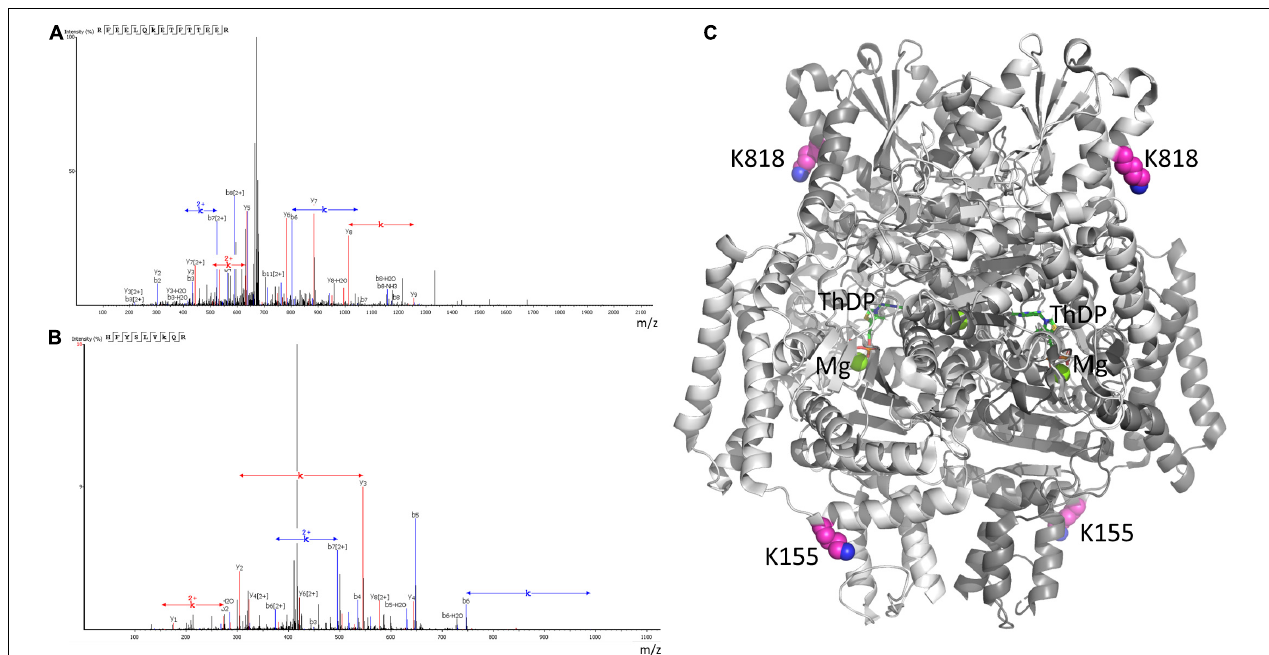
FIGURE 8 | Mass-spectrometric identification of OADH glutarylation. The glutarylation of lysine K155 and K818 is identified by LC-MS in human recombinant OADH expressed in yeast. (A) The spectra of the peptide with glutarylated K155, namely RFEELQK(+114.03)ETFTTEER, m/z = 686.3347, retention time (RT) = 96.49; (B) the spectra of the peptide with glutarylated K818, namely HFYSLVK(+114.03)QR, m/z = 431.2349, RT = 82.38; (C) localization of the identified glutarylated residues (the carbon atoms marked in pink) in the OADH dimer. The available structure of the enzyme dimer crystallized with Mg 2 + ThDP (PDB: 6SY1) is shown, with the active site regions defined by ThDP and magnesium ions (shown in